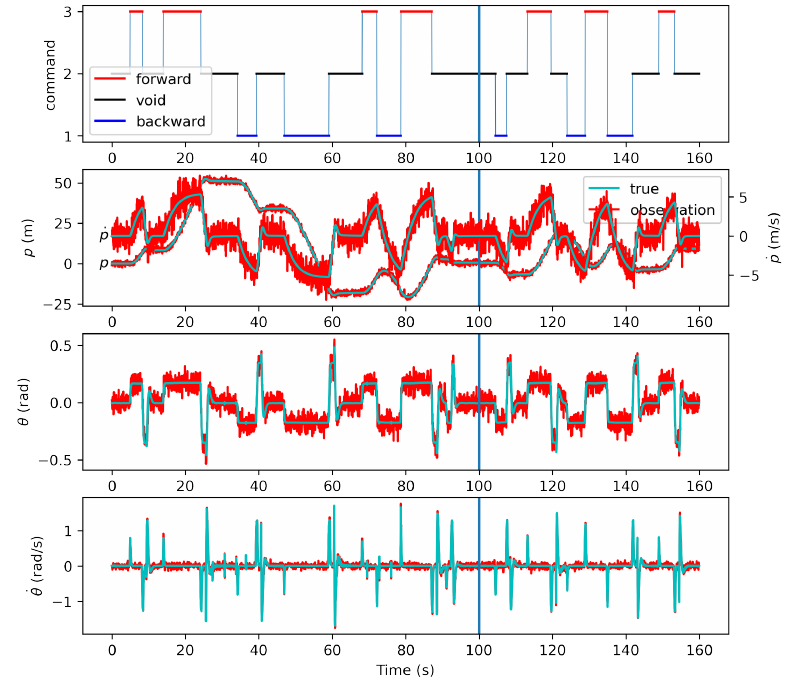
Figure 7. The human command and the true state and observation trajectories.